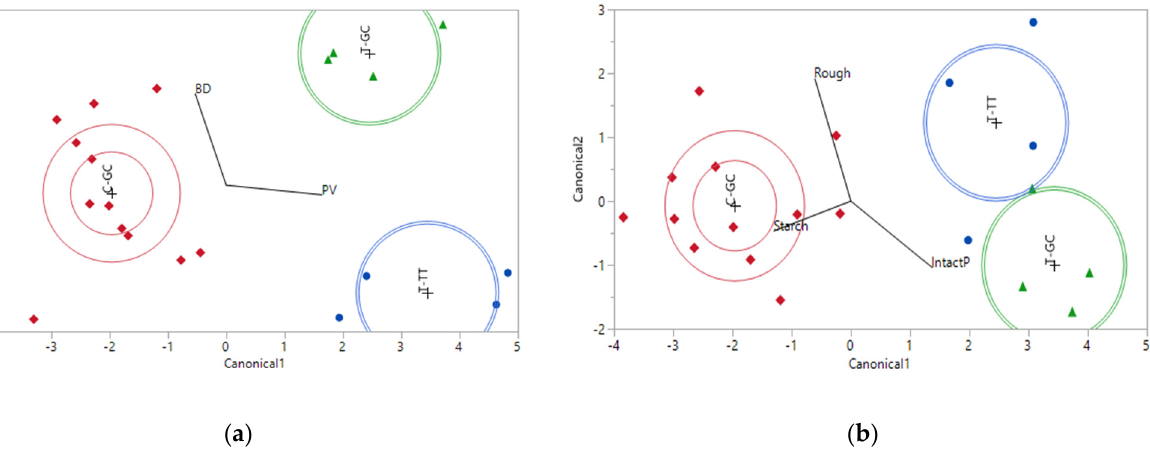
Figure 4. Linear discriminant analysis of RVA parameters ( a ) and texture attributes ( b ) in association with three high amylose haplotypes.